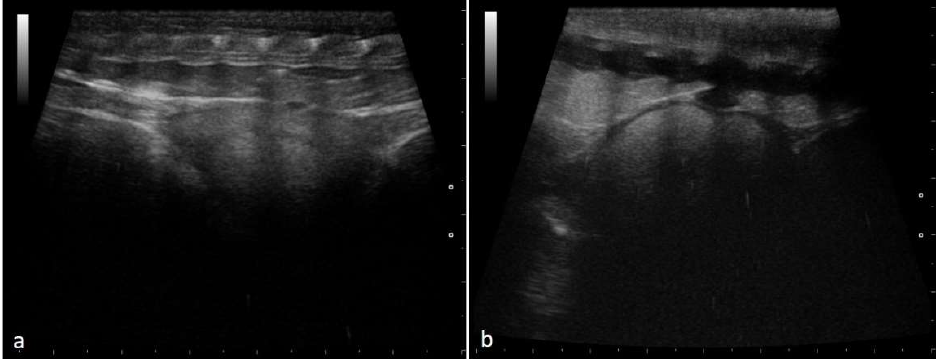
Figure 9. Postovulatory follicles in a female boa at 28 days ( a ) and 32 days ( b ) after ovulation. A small rounded anechoic peripheral formation was highlighted in 88.5% of subjects who carried the pregnancy to term.